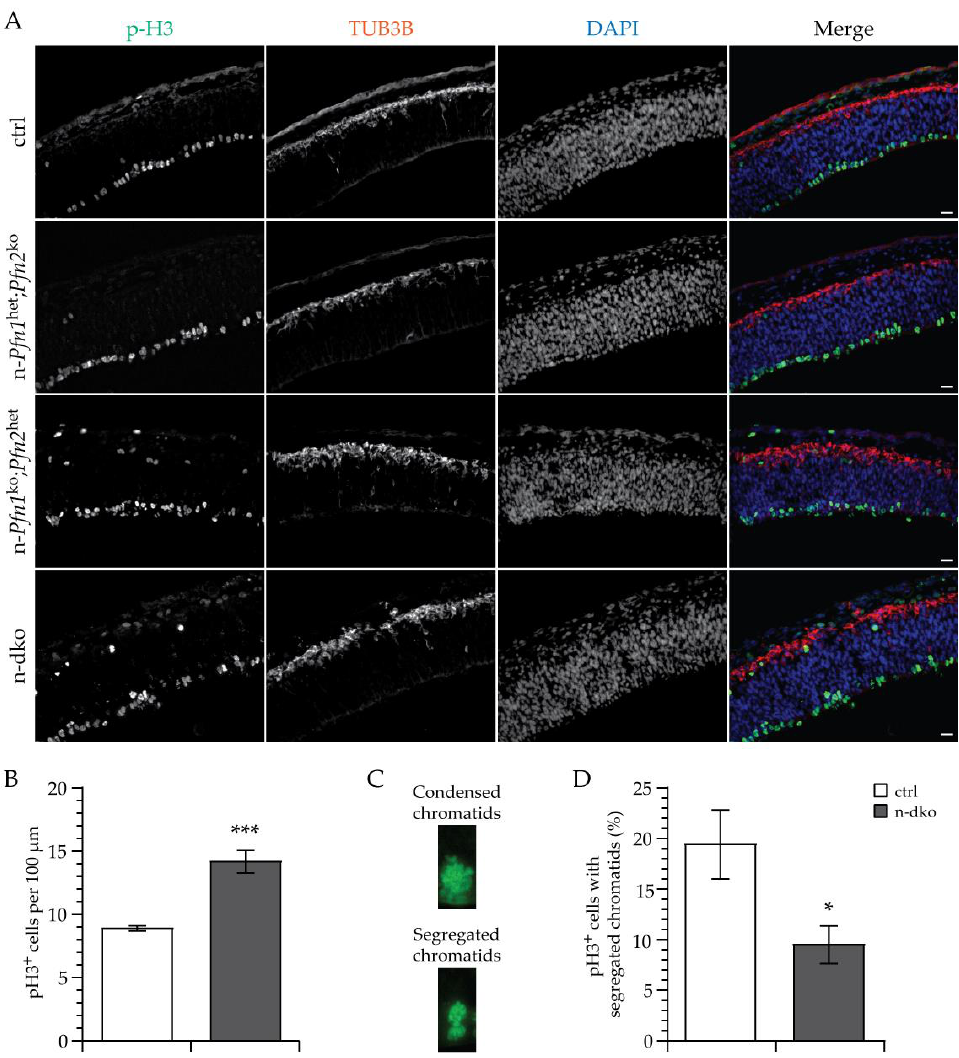
Figure 4. Mitotic neural precursor cells (NPCs) in the VZ are disarrayed and increased in E11.5 n-dko embryos. ( A ) Immunofluorescence staining of E11.5 cryosections with anti-p-H3 (S10 phospho- histone 3) antibodies, green, to label dividing NPCs, anti-TUB3B ( β 3-tubulin) antibody, red, to label differentiated neurons on the pial surface, and DAPI, blue, to label cell nuclei, shows a disarrayed layer of dividing NPCs and ectopic p-H3 labeling in the forebrain region of n-dko, as well as n- Pfn1 ko ; Pfn2 het embryos. On the other hand, embryos carrying a single Pfn1 allele, n- Pfn1 het ; Pfn2 ko , appear unaffected. Scale bar: 20 µ m. ( B ) Quantification of p-H3 positive cells in the VZ of E11.5 embryos shows increased linear density in n-dko profilin mutants (14.17 ± 0.89/100 µ m) compared to controls (8.91 ± 0.20/100 µ m, two-sided Welch’s t -test p < 0.001, n = 8/2 sections/embryos for ctrl and n = 11/2 for n-dko). ( C ) Examples of p-H3-labeled condensed and segregated chromatids in NPCs, with the latter indicating the progression of cell division to the telophase stage. ( D ) Quantification of p-H3 + NPCs with segregated chromatids shows a significant 50% decrease in n-dko embryos (9.5% ± 1.87% compared to 19.42% ± 3.4% in controls, two-sided Welch’s t -test, p = 0.0215, n = 8/2 sections/embryos for ctrl and n = 11/2 for n-dko); * p ≤ 0.05, *** p ≤ 0.001. Scale bar: 20 µ